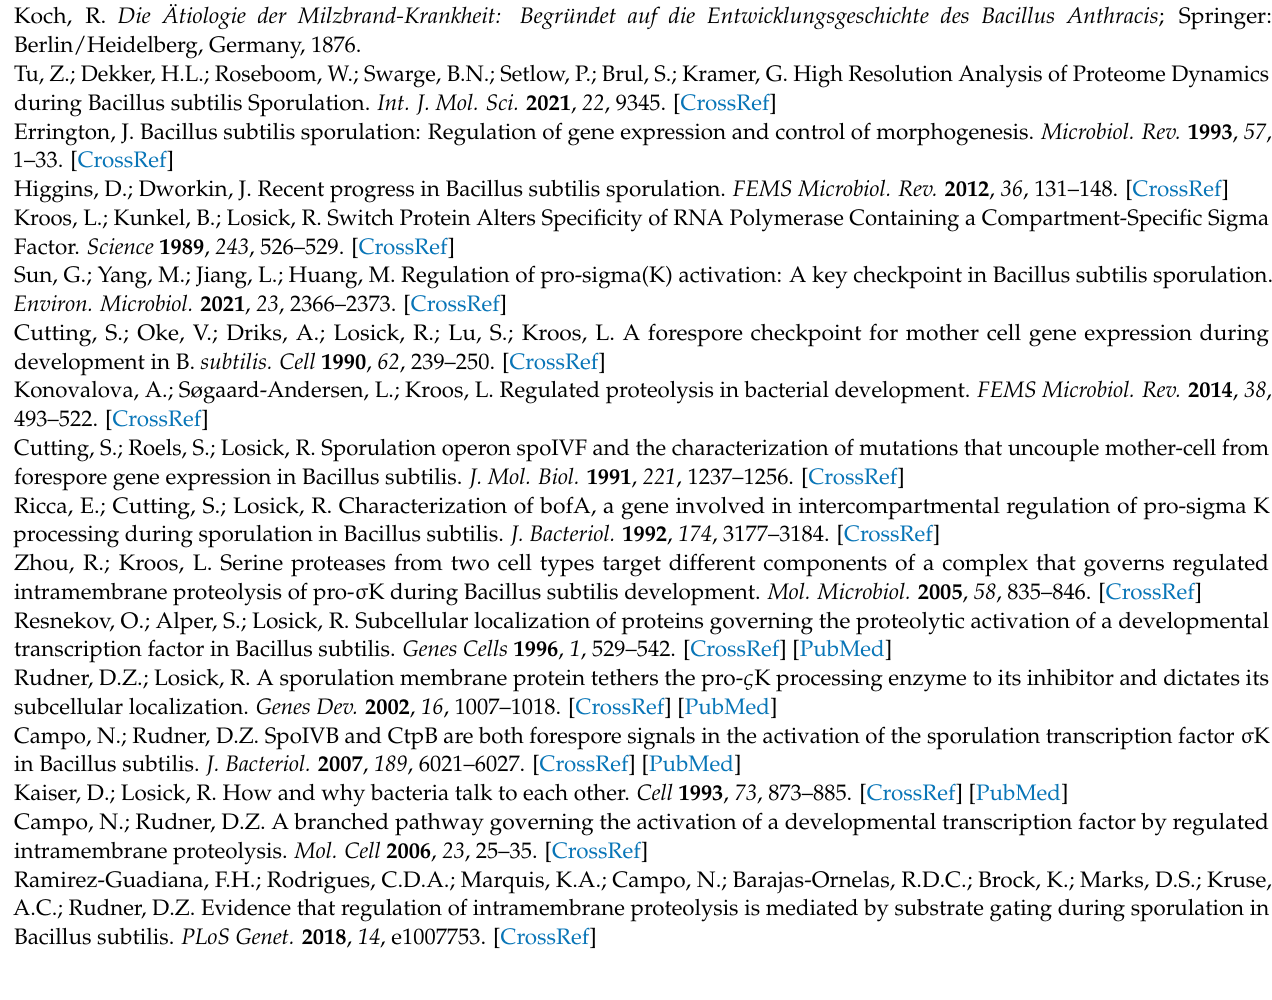
Table S3: eight hydrogen bonds and five salt bridges are involved in the interactions between BofC and SpoIVB. Table S4: construction of pET-22b(+)-BofC plasmid and expression of